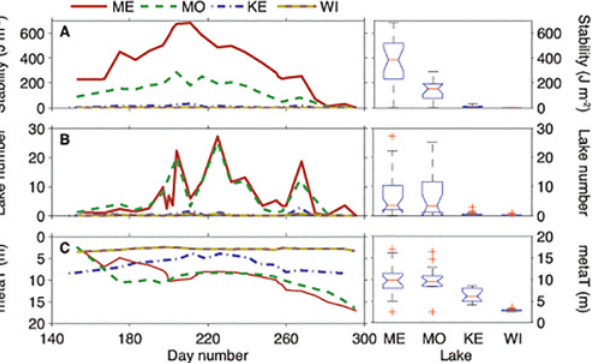
Fig 1. Time-series comparison of Schmidt Stability (SS), Lake Number (L N ), and the top of the metalimnion (metaT), which comprises the upper mixed layer, as boxplot results of one-way analysis of variance (ANOVA) of variables between the lakes. Lakes are in order from largest to smallest; left to right: ME = Mendota, MO = Monona, KE = Kegonsa, and WI =